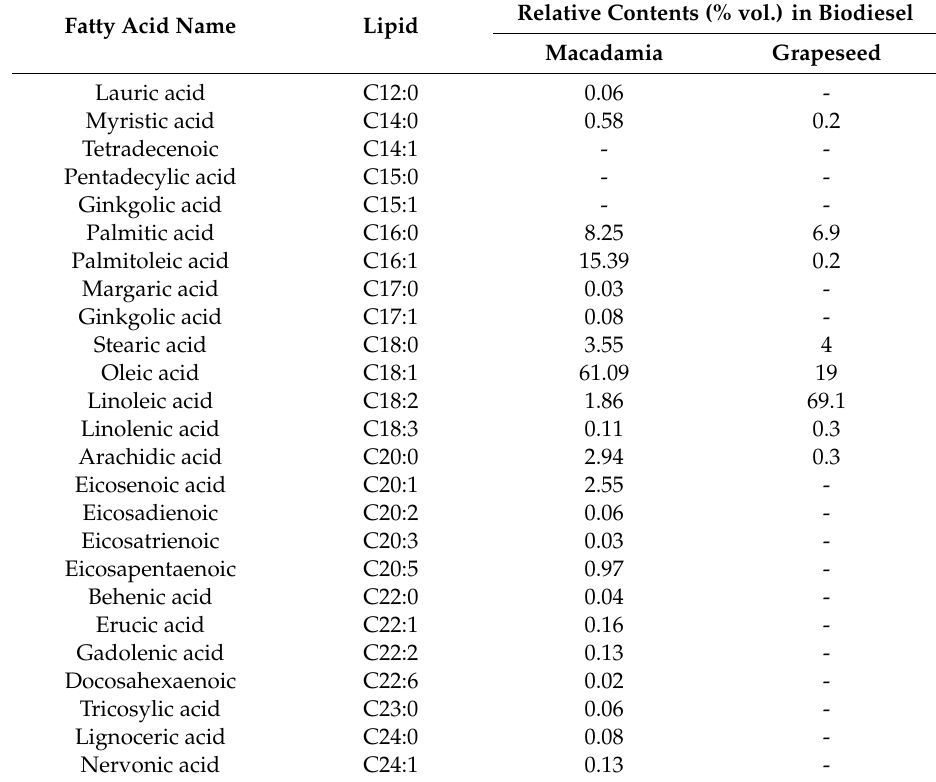
Fatty acid methyl esters (FAMEs) composition of the biodiesels measured by gas chromatography (GC) according to the ISO 11024